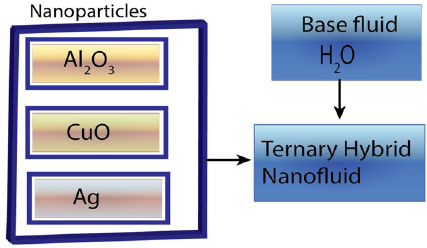
Figure 2. Organized attitude of tri-hybrid